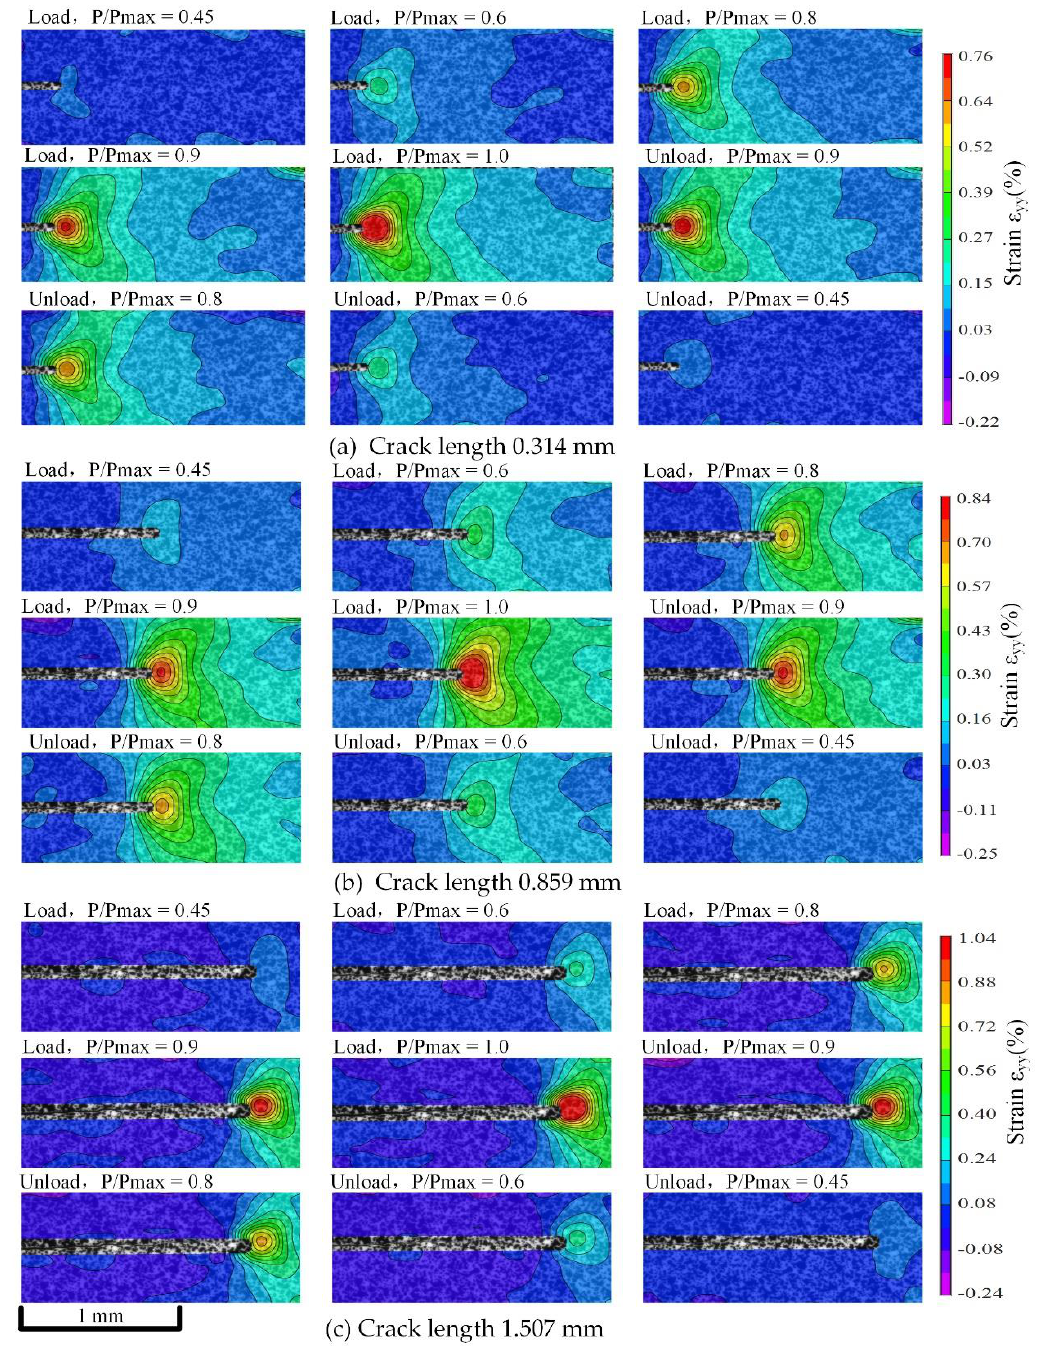
Figure 14. Strain fields’ evolution during crack closure with stress ratios of 0.4. When the stress ratio is 0.2, the obvious strain is observed at the time of P/Pmax = 0.4; when the stress ratio is 0.4, the obvious strain is observed at the time of P/Pmax = 0.45. This is basically consistent with the load when the crack turns from closing to opening